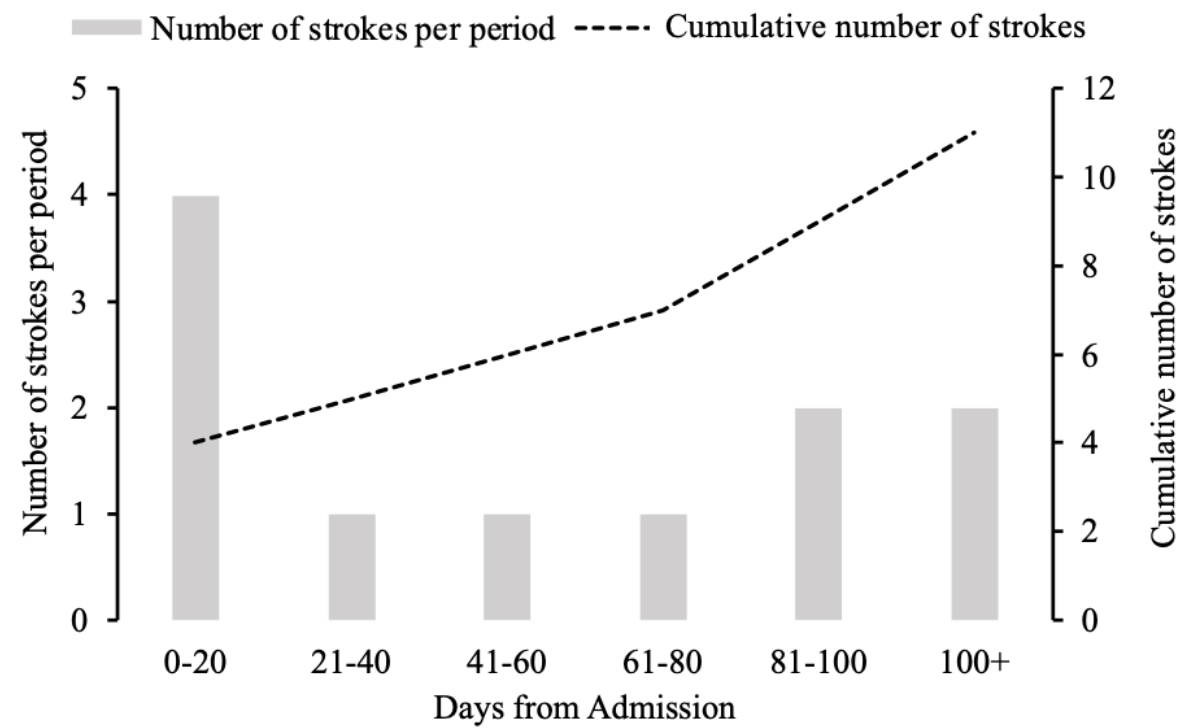
Figure 1. The distribution of cerebrovascular accidents that occurred following hospital admission. Patients with new cerebrovascular events after admission had similar burdens of comorbidities measured (CCI Recovered =3.5 + 3.40 vs. CCI CVA = 5.1 + 3.40; t [3 3;18] = 0.357, p =